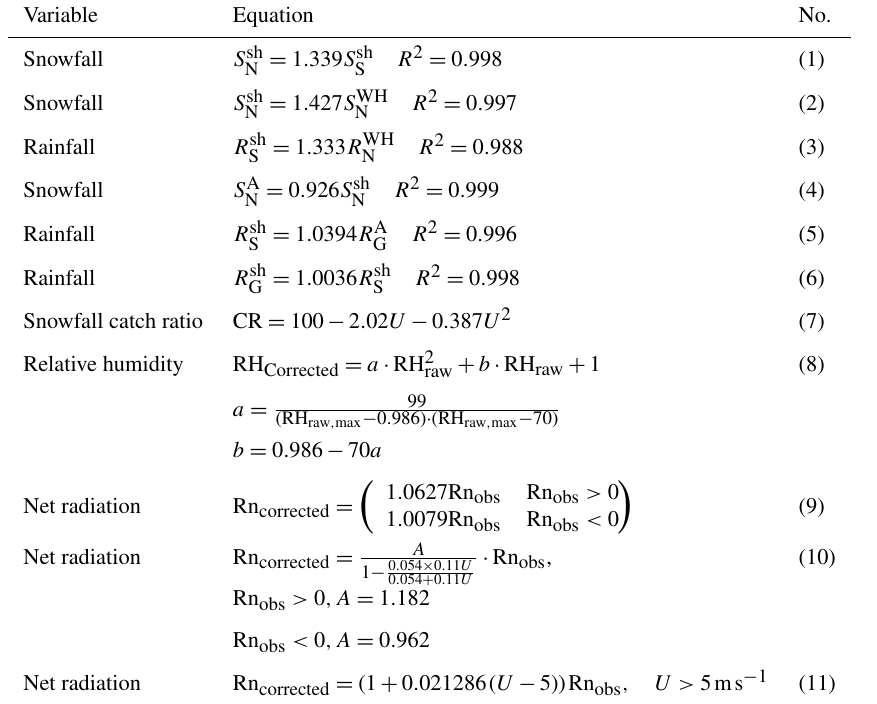
Table 4. Equations used to fill the gaps and correct the erroneous values in precipitation, relative humidity, and net radiation in the three stations representing forest, shrub tundra, and alpine biomes in the Wolf Creek Research